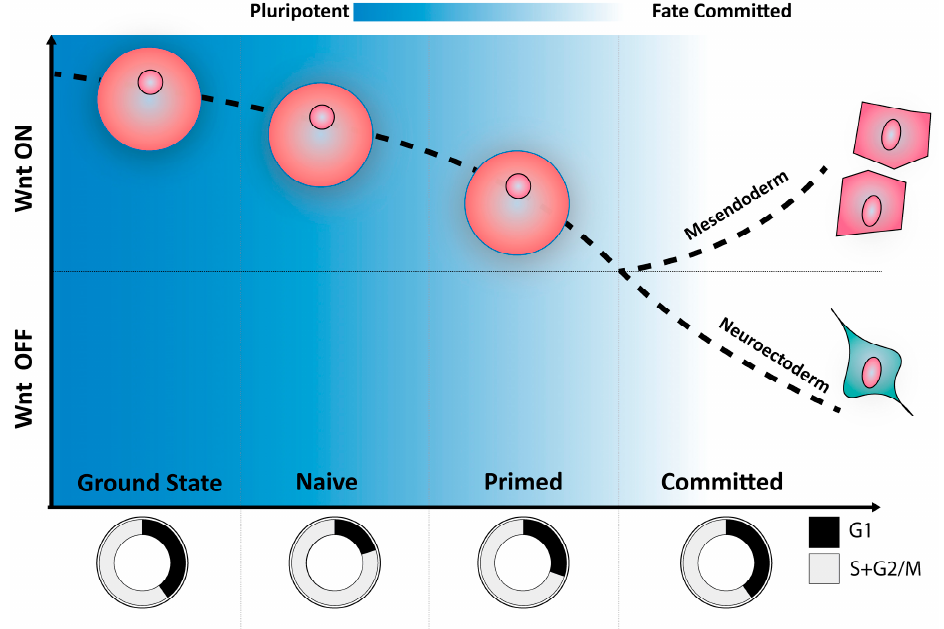
Figure 3. Wnt/ β -catenin modulation correlates with different pluripotency and cell cycle stages. In mouse embryonic stem cells (mESCs), activation of the Wnt signaling pathway maintains naive pluripotency. Naive pluripotent conditions with Wnt induction or ERK inhibition correlate with a slow-down in cell cycle progression. Once the naive state is maintained without these inhibitors (i.e., serum + Leukemia Inhibitor Factor (LIF) conditions), mESCs start to proliferate faster. The inhibition of Wnt induces the cells to differentiate towards a primed pluripotency state (epiblast stem cells (EpiSCs)). For further differentiation commitment, activation is crucial to induce mesendoderm cell fate, while an acute repression of the pathway will generate neuroectoderm cells. In addition, cells differentiating show a classic slow cell cycle.